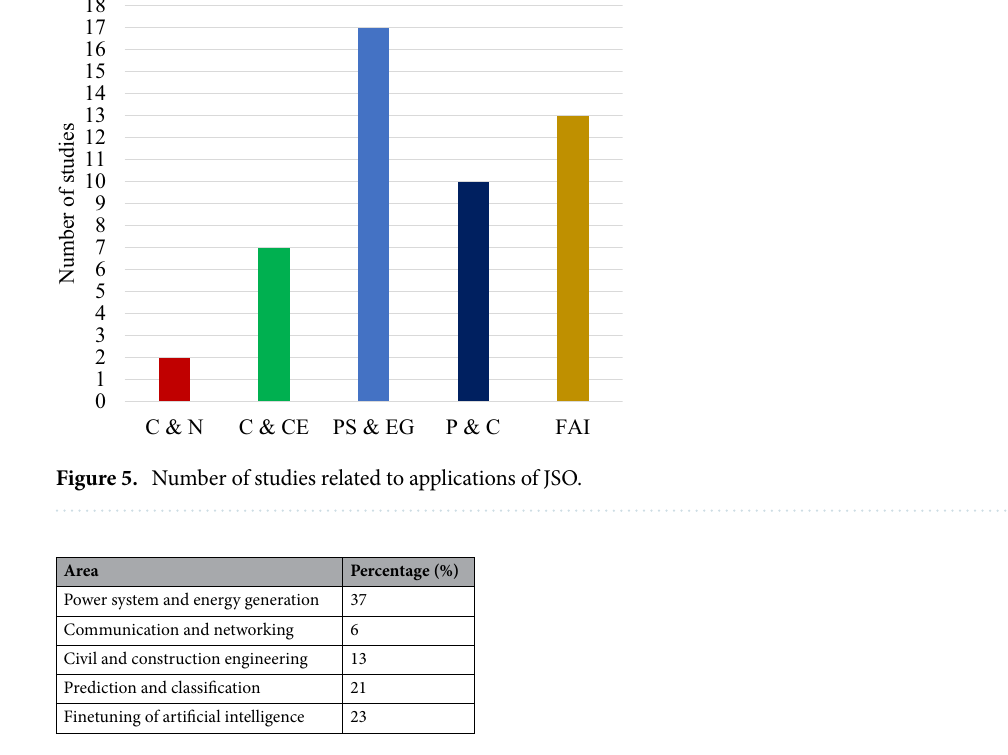
Table 3. Applications of JSO.